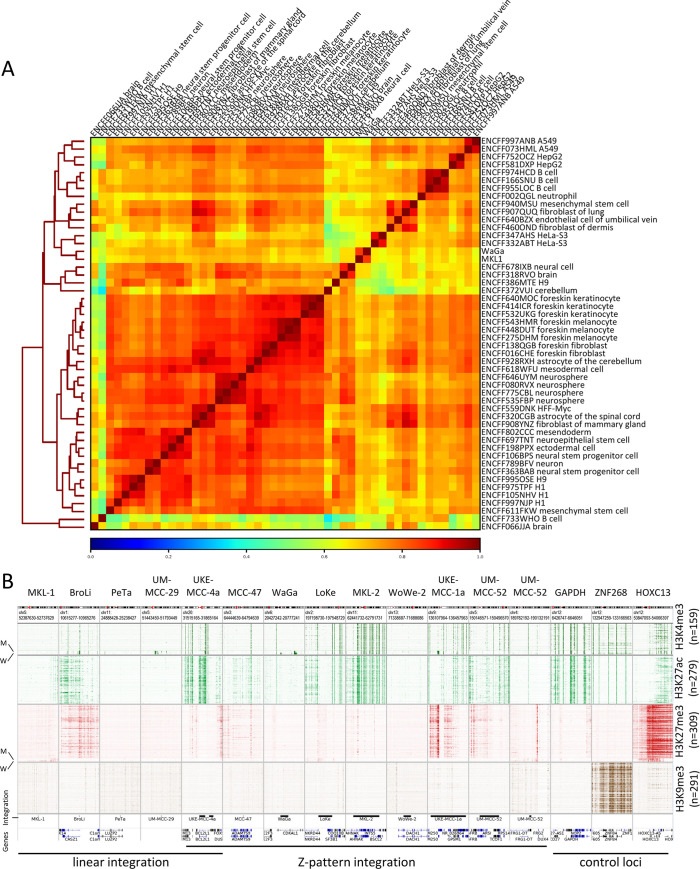
Epigenetic properties of MCC cell lines and MCPyV integration sites.(A): Correlation and clustering of H3K4-me3 profiles from WaGa and MKL-1 in comparison to 48 selected tumor cell lines and primary cells obtained from the ENCODE database. Correlation and clustering were performed using DeepTools and are based on MACS2 identified H3K4-me3 peak regions in the WaGa cell line. (B): Cellular chromatin environment at integration sites of MCC cell lines (350kbp window). Heat maps represent ENCODE ChIP-Seq signals of different cell types and cell lines (n is given beneath each modification) and include MKL-1 (M) and WaGa (W) data as indicated for H3K4-me3 and H3K27-me3 (please note increased track height of MKL-1 and WaGa for better visualization). Start and end of the bars in the integration track indicate positions of the left and right junctions of the respective integration site. Endogenous positive control regions were included for each histone modification using the same magnification (GAPDH: H3K4-me3 and H3K27-ac; ZNF268: H3K9-me3; HOXC13: H3K27-me3).